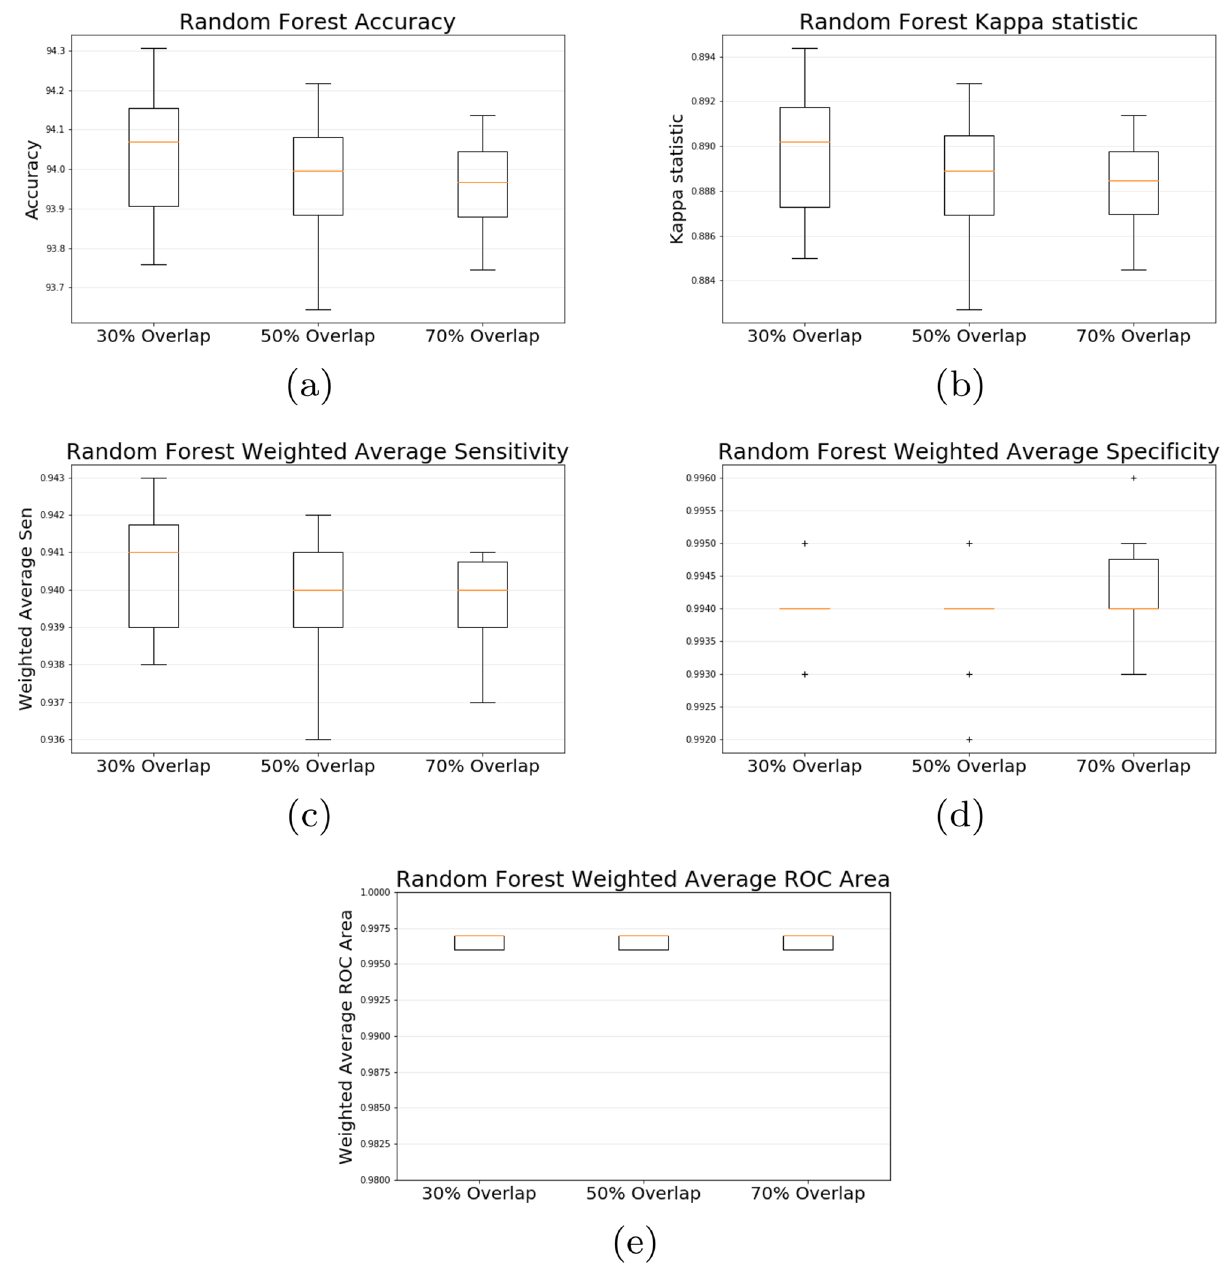
Figure 7. Random Forest accuracy ( a ), kappa ( b ), weighed average sensitivity ( c ), specificity ( d ) and ROC area ( e ) in 30%, 50% and 70% overlap